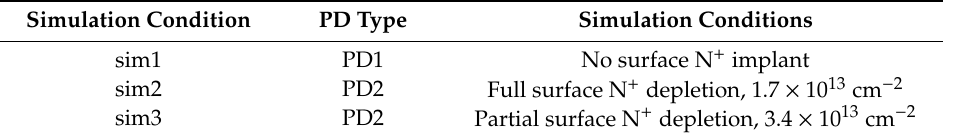
Table 2. Simulation conditions